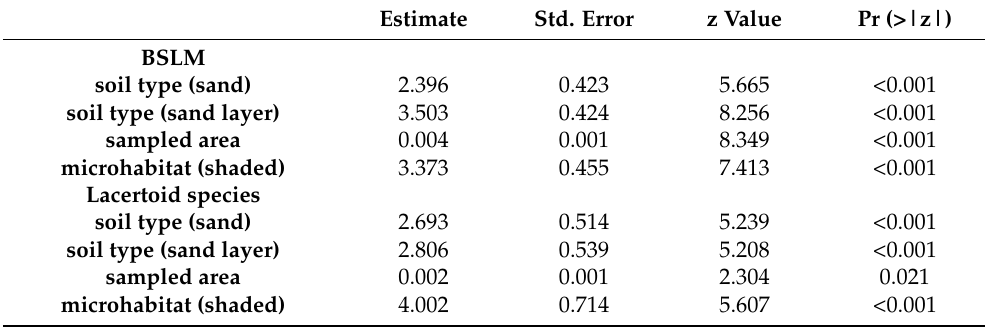
Figure 6 . ( A ). Variation in the density of lizards with different morphotype across 284 samples obtained at 6 localities of Northeastern Brazil. ( B ). Comparison of the density of lizards with different morphotype. We only used sampling plots where both morphotypes were found. Colors indicate or connect mean values for each species. Table 3. Effects of sand availability, presence of vegetation, and sampling unit size over 284 samples of lizards of two different morphotypes, made in 5 sandy sites in Northeastern Brazil. Z-values show soil type and microhabitat affected the abundance of BSLM lizards more than that of lacertoid lizards. Additionally, BSLM numbers increased more steeply with the size of the sampling